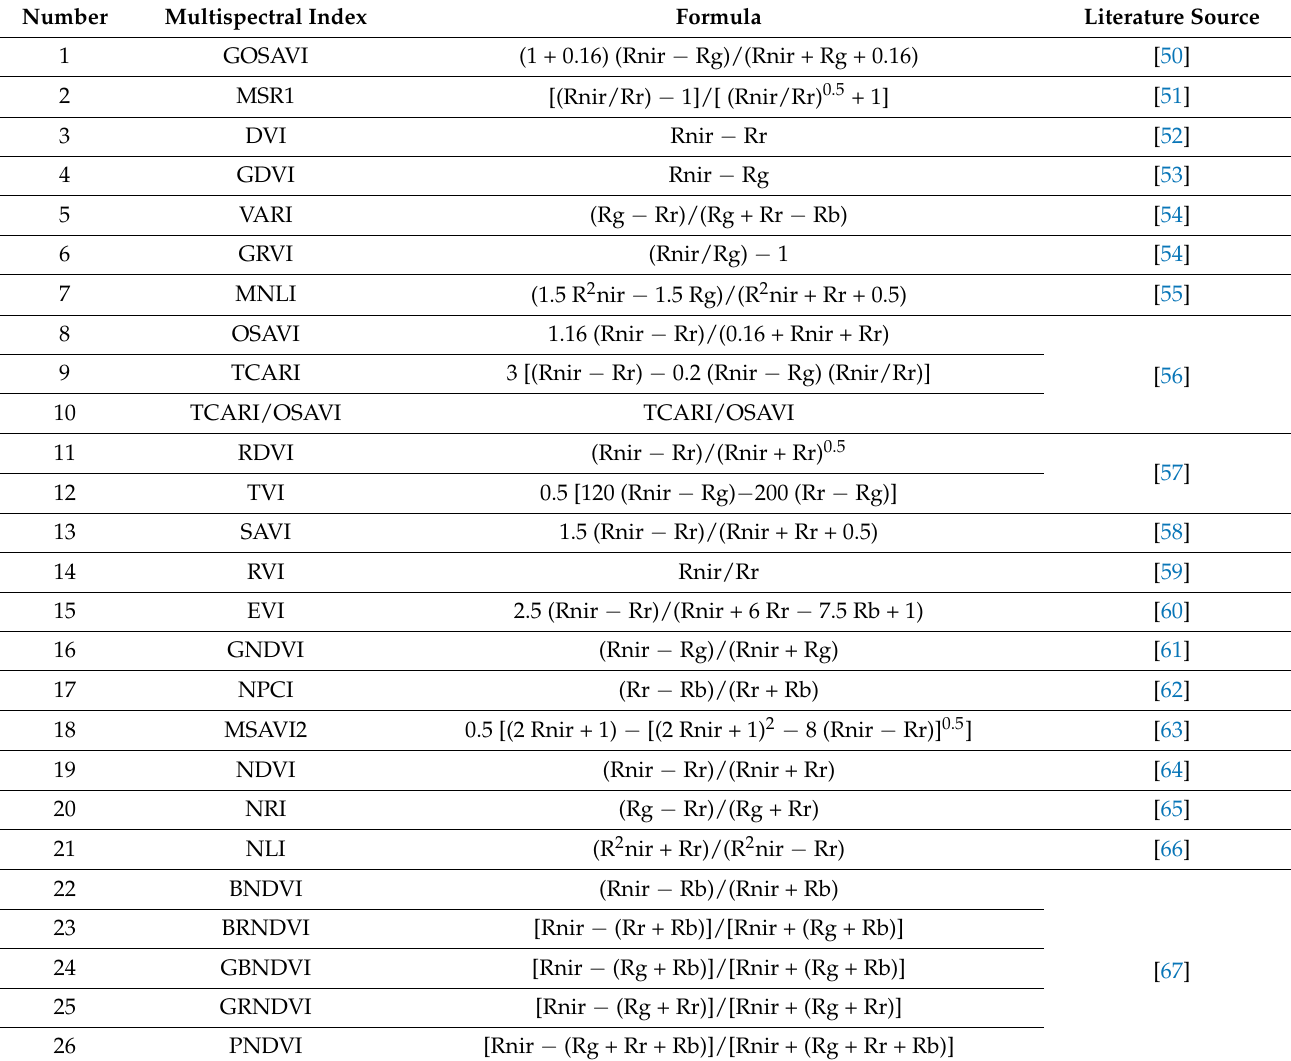
Table 1. Multispectral reflectance indices used to estimate nitrogen content of crops in this